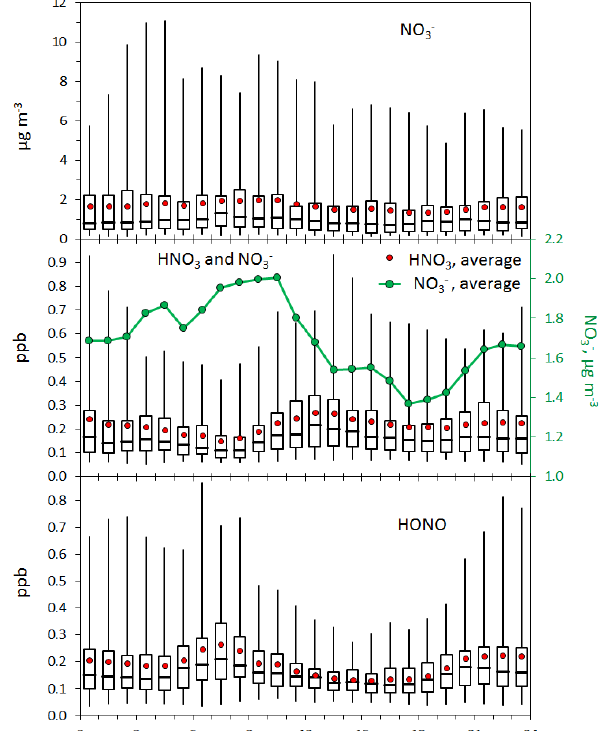
Fig. 9. Diurnal cycle of nitrate in PM 10 , nitric and nitrous acids in March–May 2010. The box represents the 25th to 75th percentile range, the bars the 95 percent range (2.5th and 97.5th percentiles), the horizontal line the median and the red circle the averages of the hourly-averaged data of each hour. Note: the average nitrate diurnal cycle is presented also in the middle panel with a different scale than in the upper panel, in order to highlight the